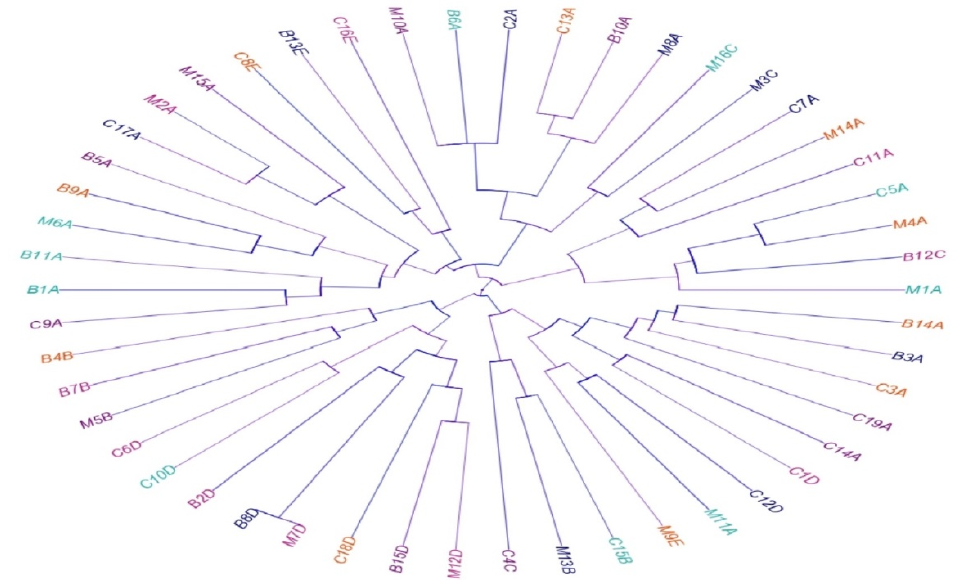
Figure 4. Dendrogram showing the relatedness of C. perfringens isolated from beef (B), chicken meat (C), and milk (M) samples as determined by the antimicrobial resistance and toxin gene profiles. The C. perfringens toxinotypes are indicated with different colors in the dendrogram to denote the specificity of various toxinotypes.